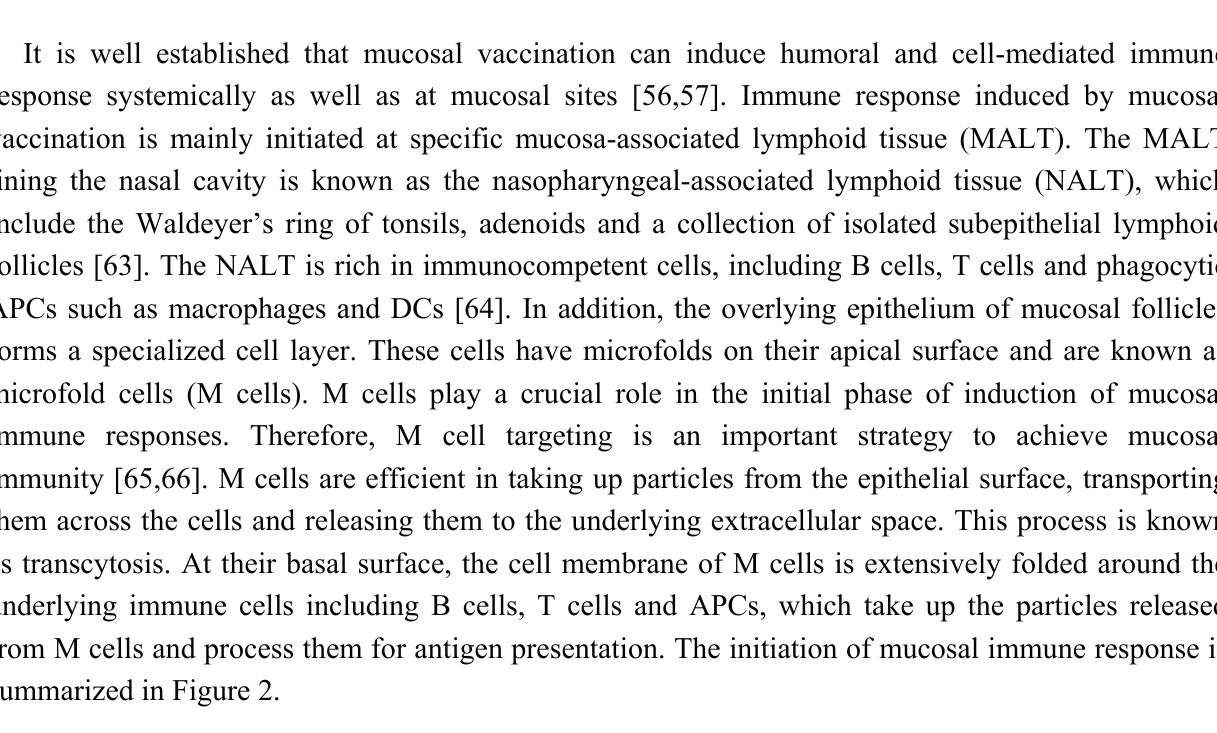
Figure 2. The initiation of mucosal immune response. Particles are taken up by M cells and transported to the underlying immune cells through transcytosis. Dendritic cells (DCs) at mucosal site may migrate to the nearest draining lymph node to present antigen to T